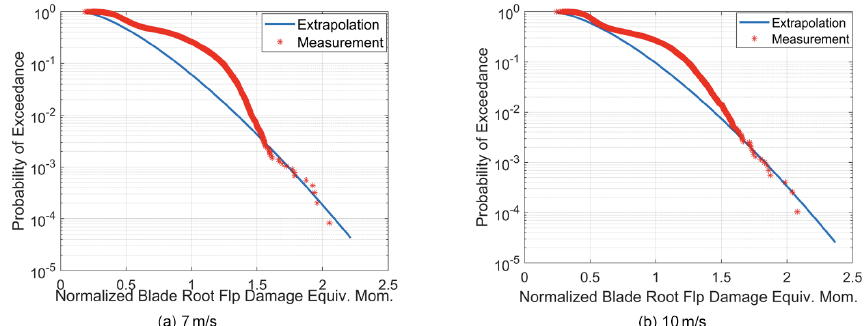
Figure 5. Validation of the stochastic extrapolation method with the measured 1-year median rank of the DEL.